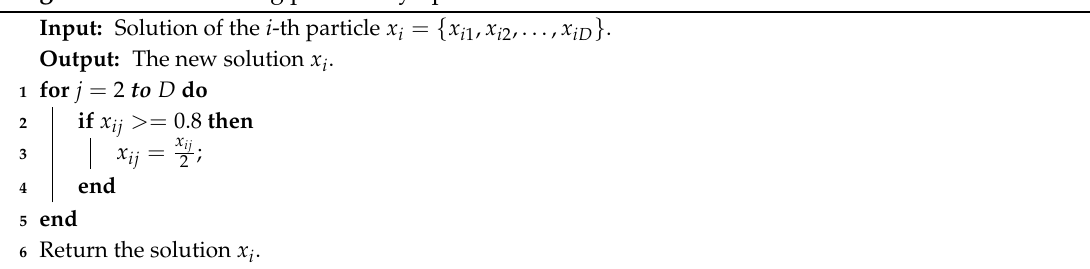
Algorithm 2: Decreasing probability